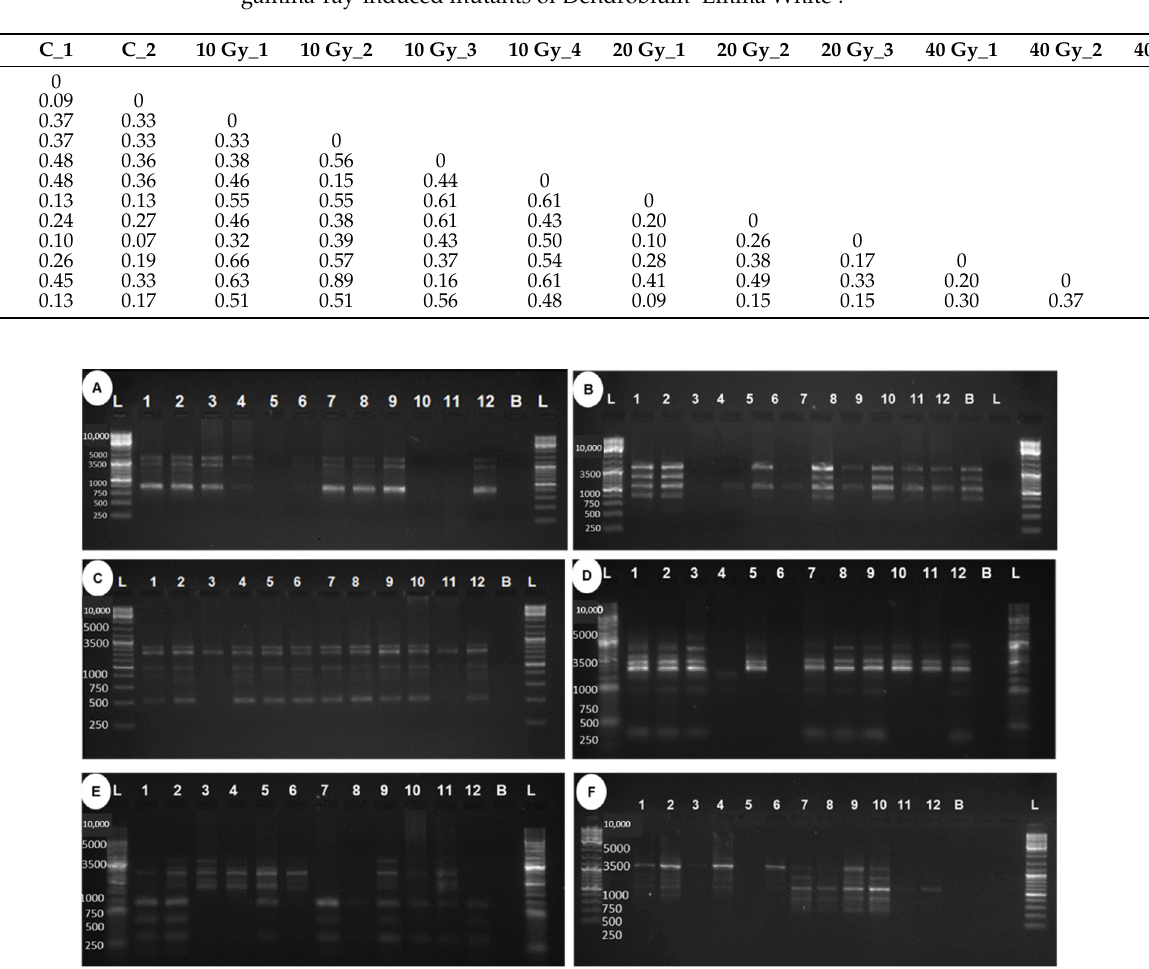
Figure 6. Random amplified polymorphic DNA (RAPD) polymorphism in gamma-ray-induced mutants of Dendrobium ‘Emma White’. Total genomic DNA was isolated from in vitro young leaves of control and mutant plantlets using a modified CTAB method for RAPD marker level study to analyze the radiation-induced genetic variability in ‘Emma White’. Twenty-eight decamer RAPD primers were used, out of which six primers (OPB 12, OPA 4, OPAW 13, OPAW 17, OPB 5, OPF 1) that produced clear and scorable bands were used to generate RAPD binary matrix. Bands were scored as the presence (1) or the absence (0) for control and mutant DNA samples. DNA ladder (lane